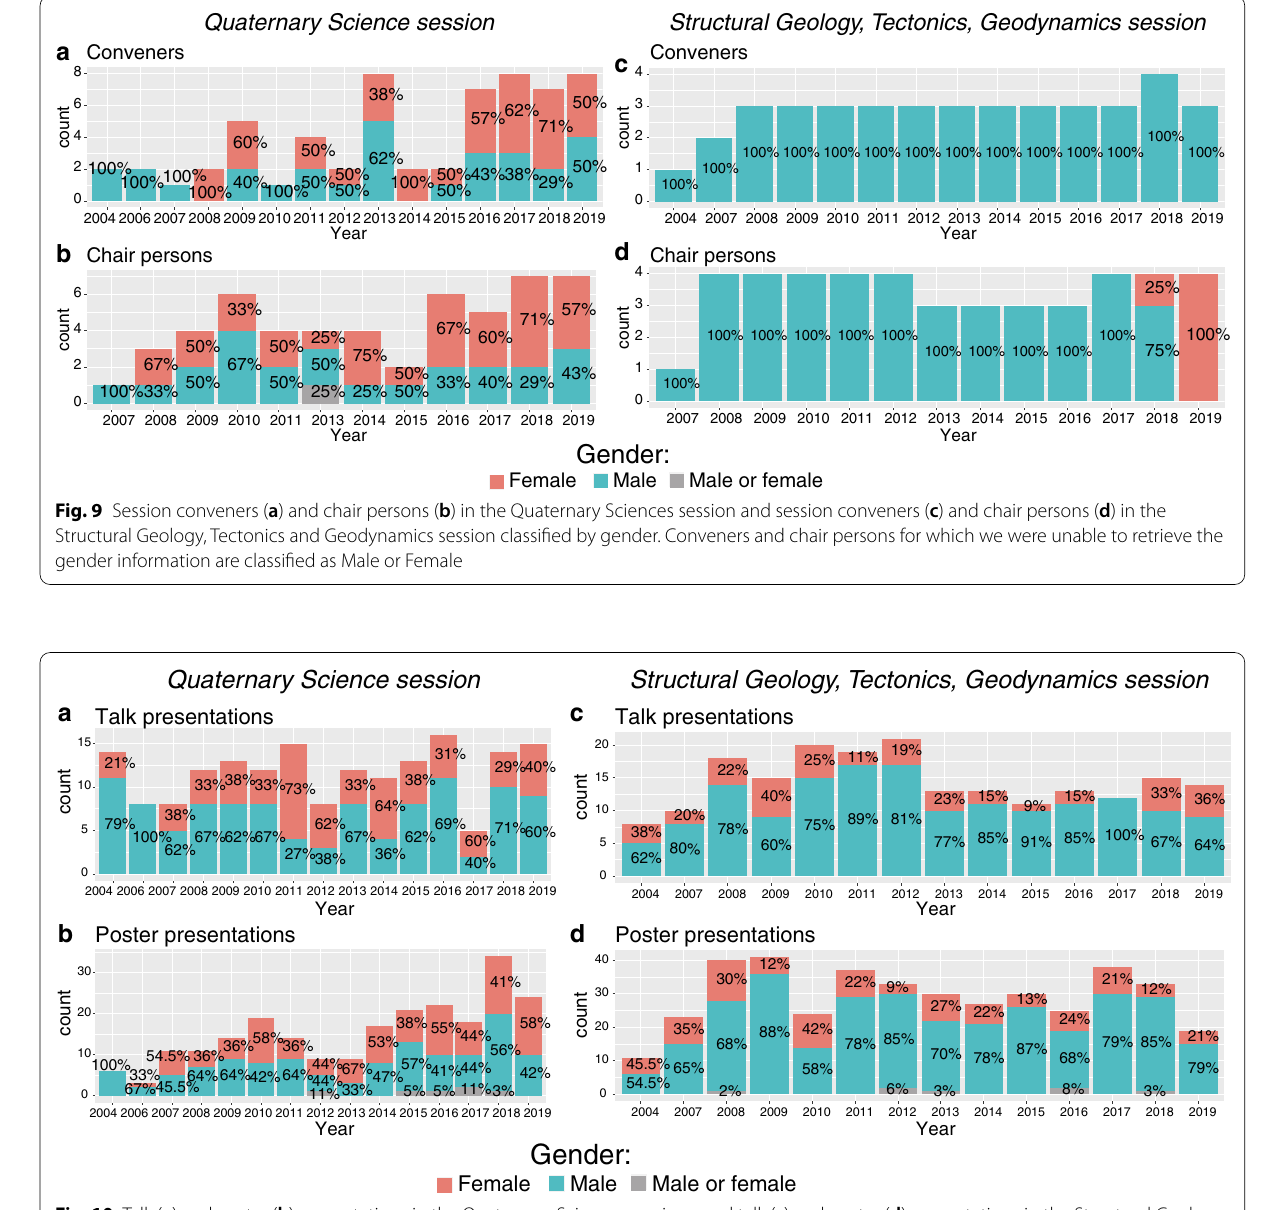
Fig. 10 Talk ( a ) and poster ( b ) presentations in the Quaternary Sciences sessions, and talk ( c ) and poster ( d ) presentations in the Structural Geology, Tectonics and Geodynamics sessions. Authors for which we were unable to retrieve the gender information are classified as male or